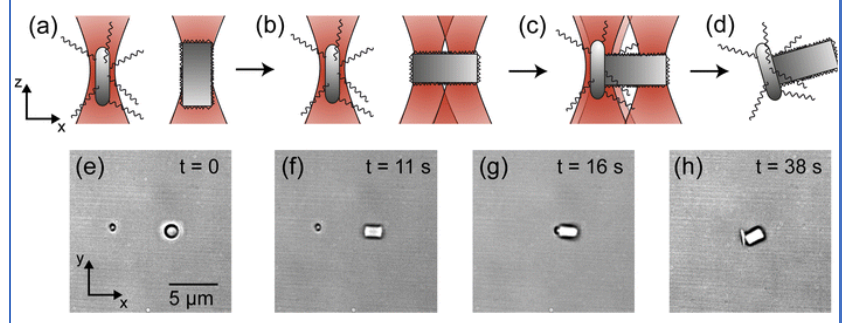
Figure 7. Optical assembly of bio-hybrid micro-robot [115]. ( a ) HOTs trap bacterium and zeolite L crystal. ( b ) The orientation of zeolite L crystal is rotated by a two-spots HOT. ( c ) HOT assembles them together. ( d ) Trapping laser is turn off, then bacterium–zeolite L living machine utilizes the bacterium’s flagella to swim on its own. ( e – h ) Top views of the experiment during the assembling process ( a – d ).